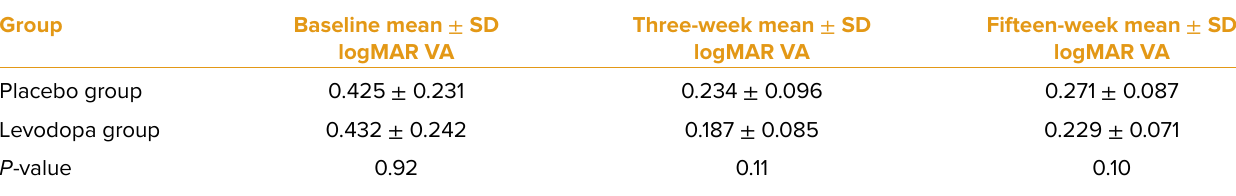
Table 2. Visual acuities of patients in the placebo and levodopa groups at each examination